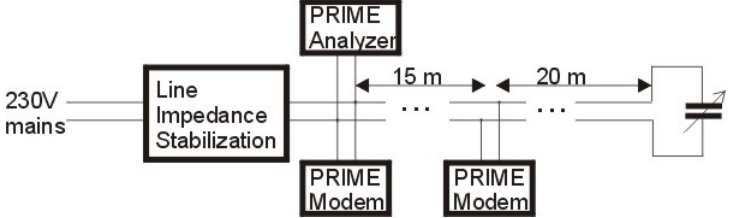
Figure 6. Schema of the circuit used for FER vs. capacitance characteristic